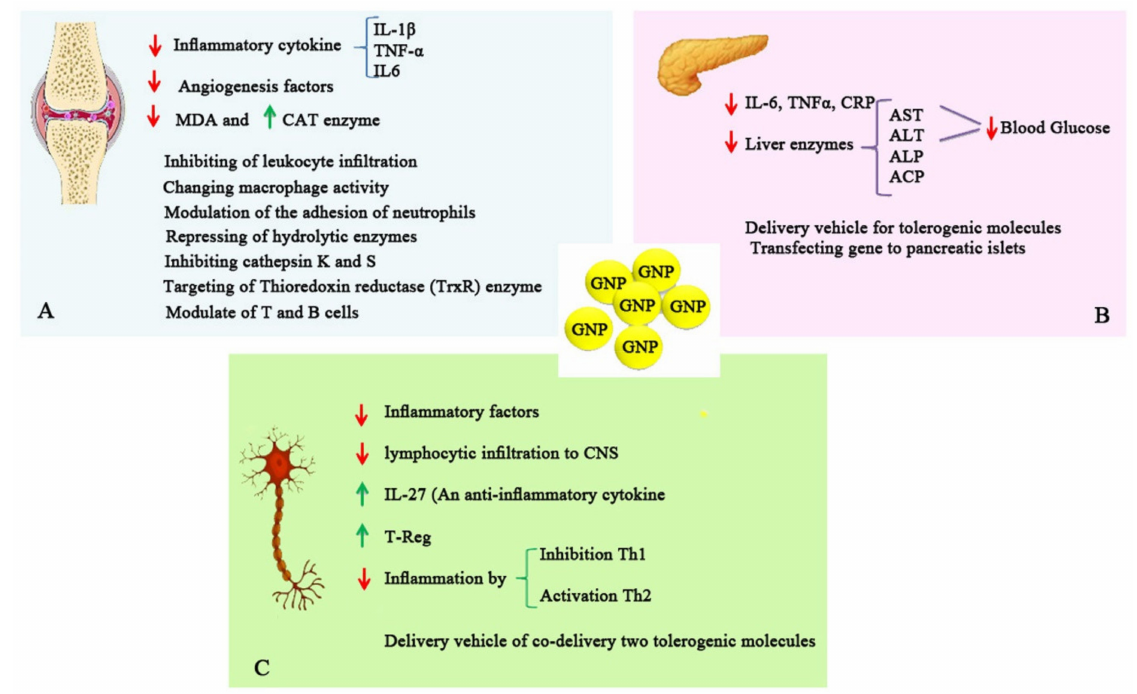
Figure 3. Simplified illustration of immunomodulatory effects of GNPs and their therapeutic applications in autoimmune diseases, including ( A ) rheumatoid arthritis, GNPs exert anti-inflammatory and anti-oxidant effects; ( B ) diabetes, anti- inflammatory and anti-oxidant effects, and their application as a gene delivery carrier; and ( C ) multiple sclerosis; anti- inflammatory and anti-oxidant effects accompanied by application as a delivery system to inducing